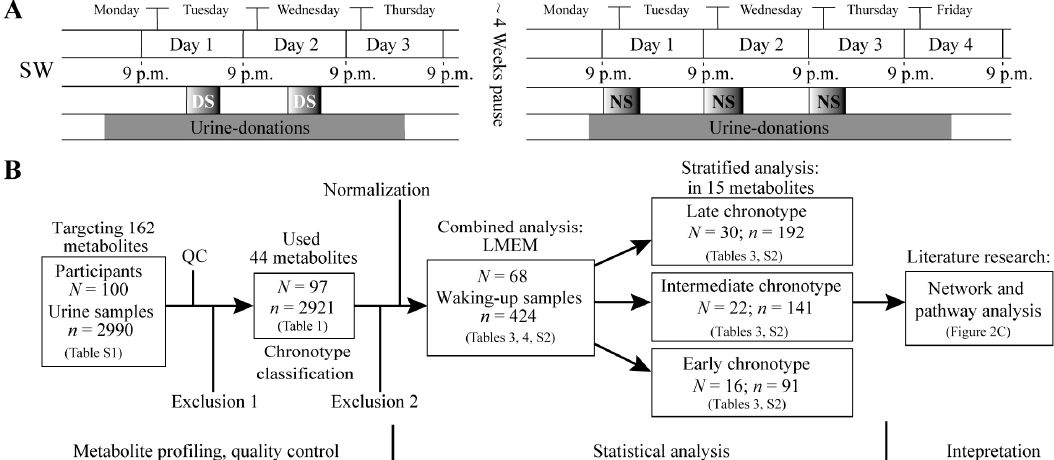
Figure 1. Study design and work flow for night shift and day shift comparison. Plot ( A ) shows an overview for nurses in SW (working both day and night shift) performing two shifts from Monday to Friday in day shift (DS) and night shift (NS) respectively with around a 4 week pause in between the study blocks. Boxes labelled DS indicate working hours in day shift, boxes labelled NS indicate working hours in night shift. Throughout the whole shift and observation period, urine samples were collected (grey boxes). Day 1 to day 4 lasts from 9 p.m. to 9 p.m. the next day and defines the time periods for comparison of day shift and night shift metabolic profiles; Plot ( B ) demonstrates an overview of the urine sample collection and exclusion, as well as the consecutive statistical and pathway analysis. Exclusion 1 = Exclude participants without information on sleep; Exclusion 2 = Exclude diabetics, vegetarians and participants with extreme sleep apnoea, as well as women working only day shift. Table 1. Characteristics of participants. Characteristics of all participants, shift working group (SW) in combined and stratified analyses are shown. Means with standard deviations (SD) or number of phenotypes with percentages are shown for each group. BMI (body mass index). * Chronotype is defined as mid-sleep corrected for sleep debt accumulated over the past work week.